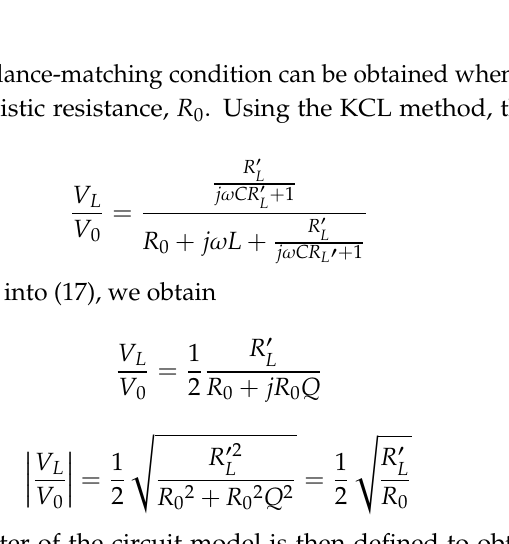
Table 1. Circuit parameters for ratio-of-resistance analysis.